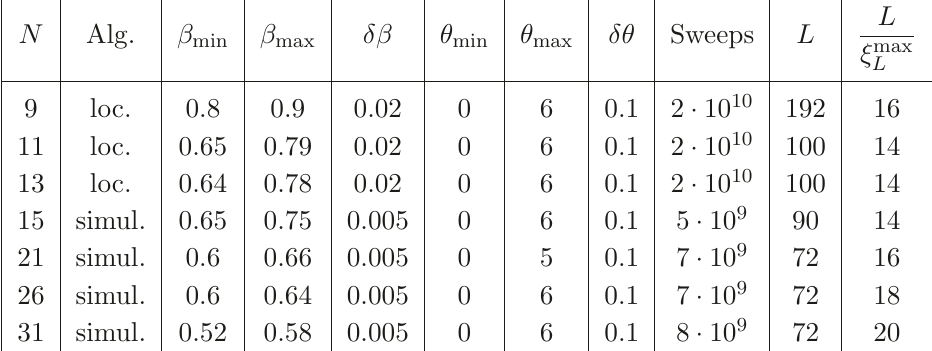
Table 1 . Summary of the simulation parameters adopted for all values of N . We also report the total accumulated statistics, in terms of total sweeps. Measures were performed every 50 sweeps. ments of ξ L needed to accurately determine ξ 2 χ . A summary of our simulation parameters L and statistics is reported in table